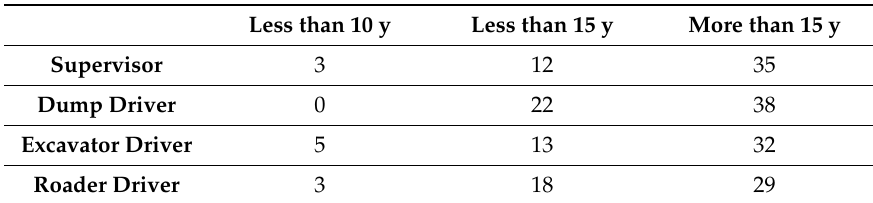
Table 1. Composition of the Group’s members.